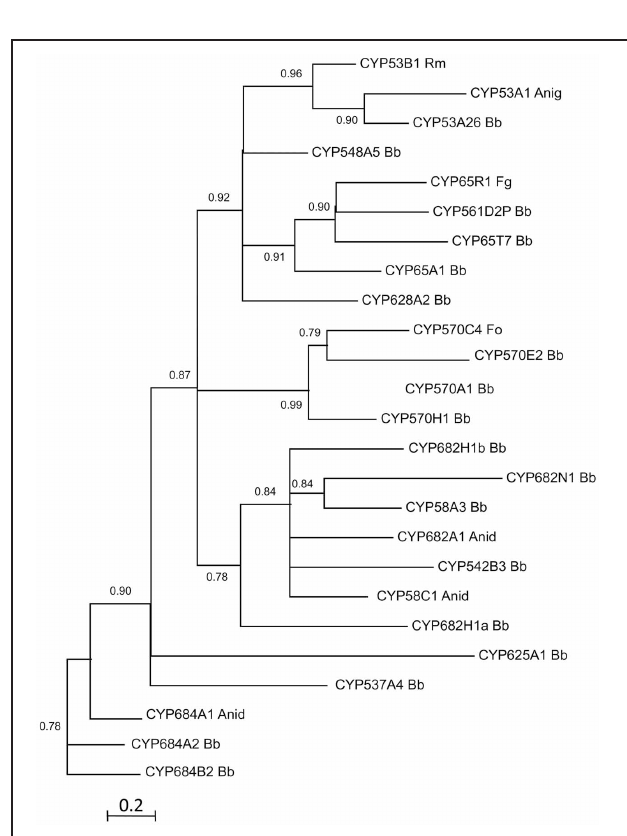
FIGURE 6 | Maximum likelihood phylogenetic tree of clan 53 cytochrome